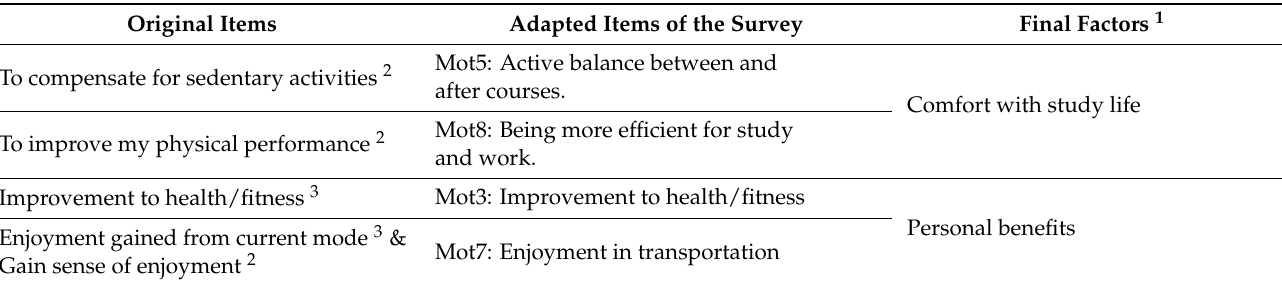
Table A2. Comparison of the final construct of motivator items newly formed by the factor analysis and content fit in this